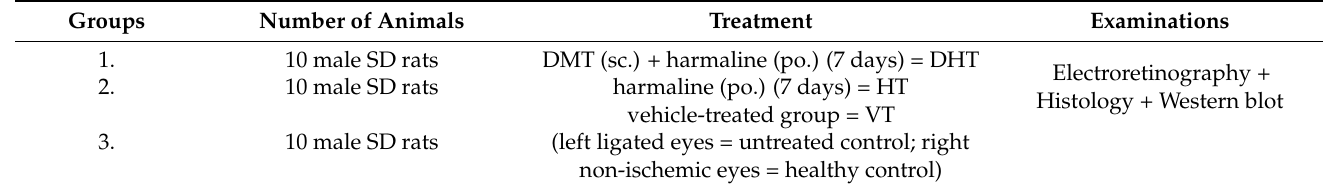
Table 1. Experimental